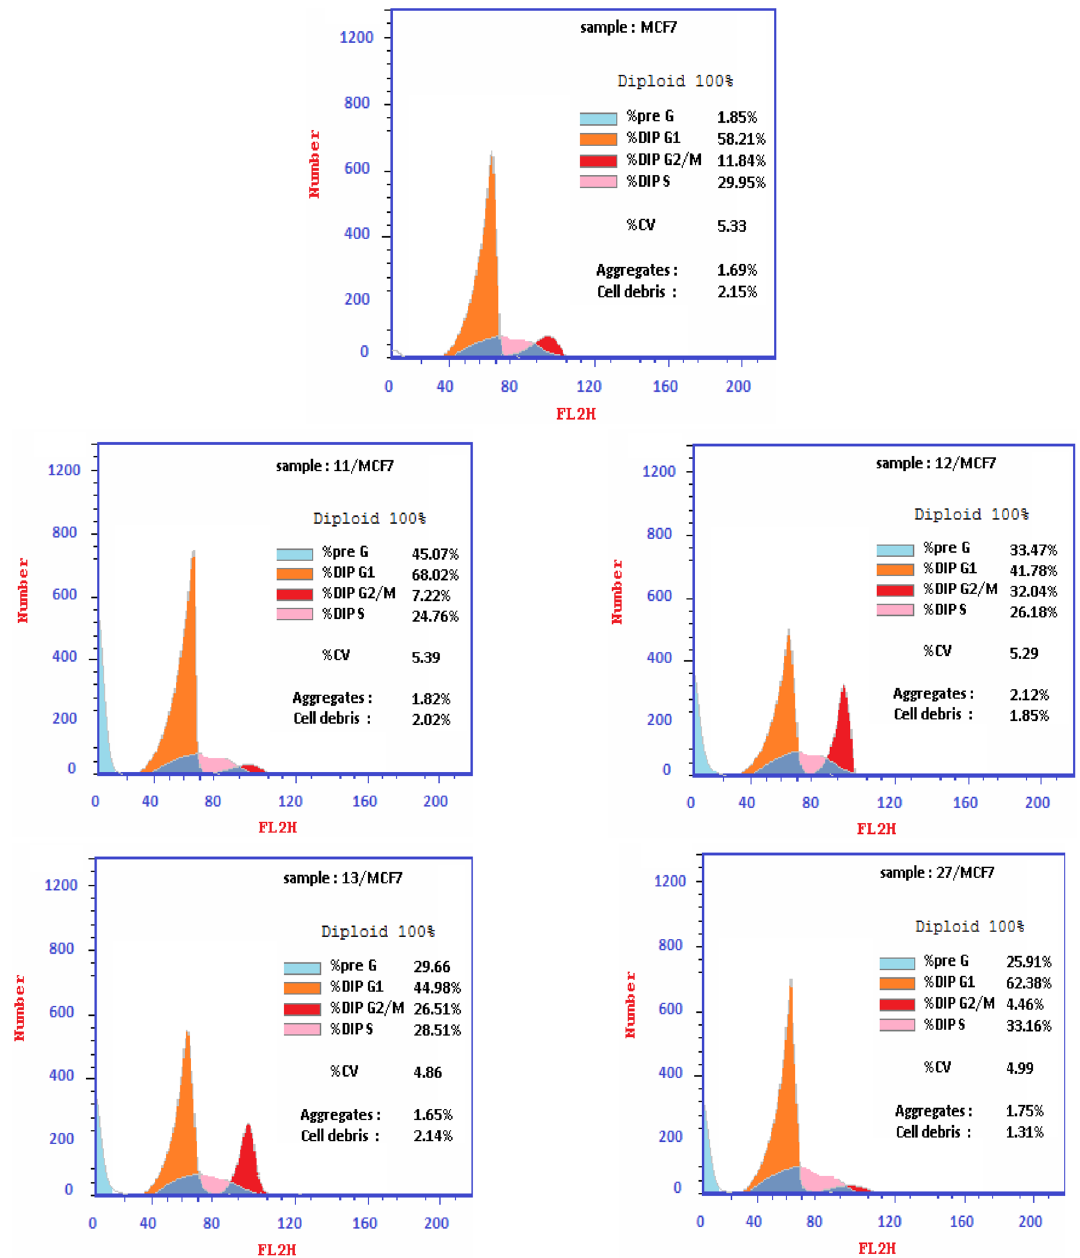
Figure 8. Flow cytometry analysis of cell cycle phase distribution in MCF-7 cells after treatment with vehicle control and the newly synthesised compounds; 11, 12, 13 and 27